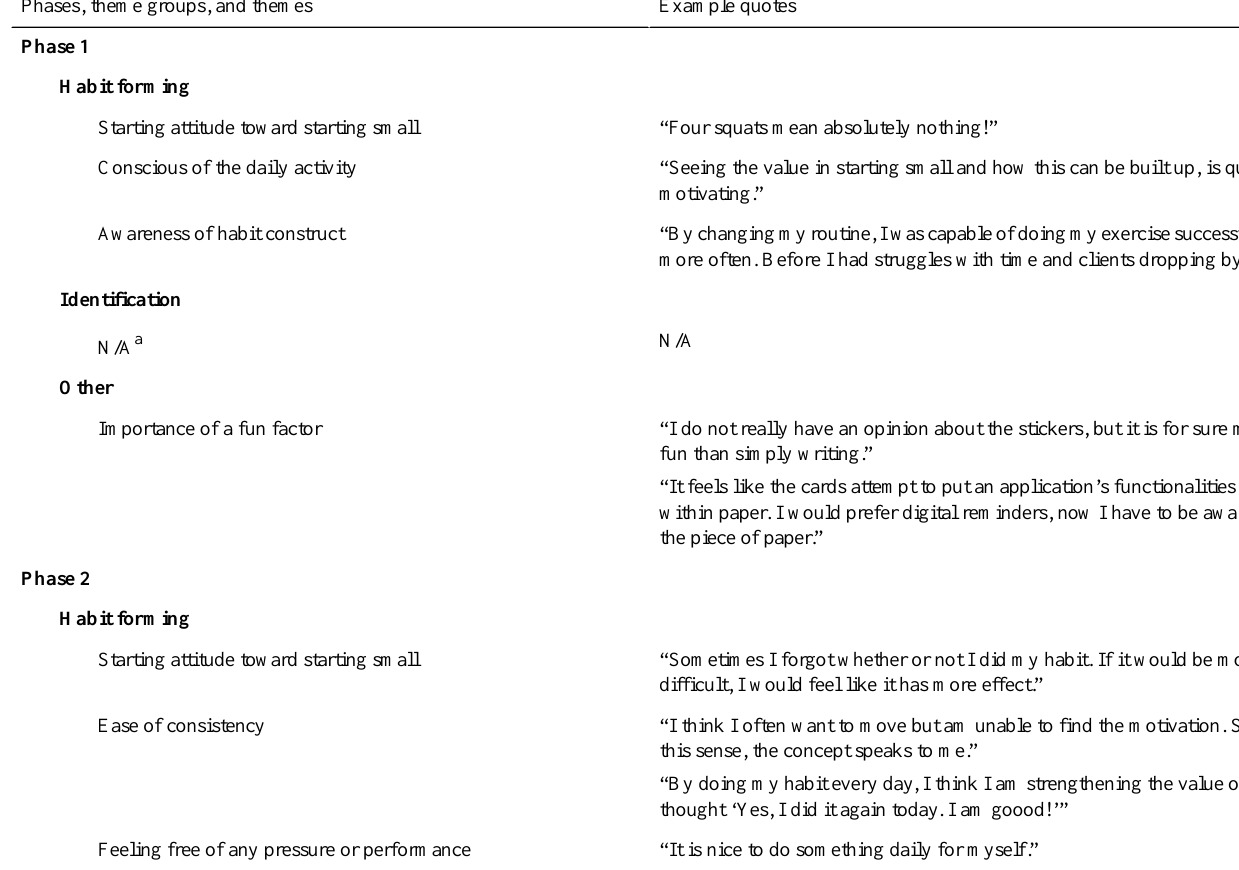
Example quotesPhases, theme groups, and